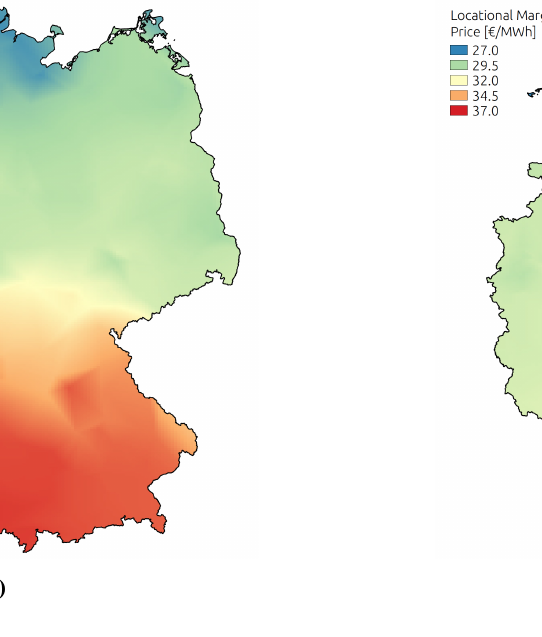
Figure 8. Locational marginal price maps for the hour of high wind energy production in Germany’s transmission system, with and without planned HVDC reinforcements in the grid. ( a ) Planned HVDC projects incomplete; ( b ) Planned HVDC projects